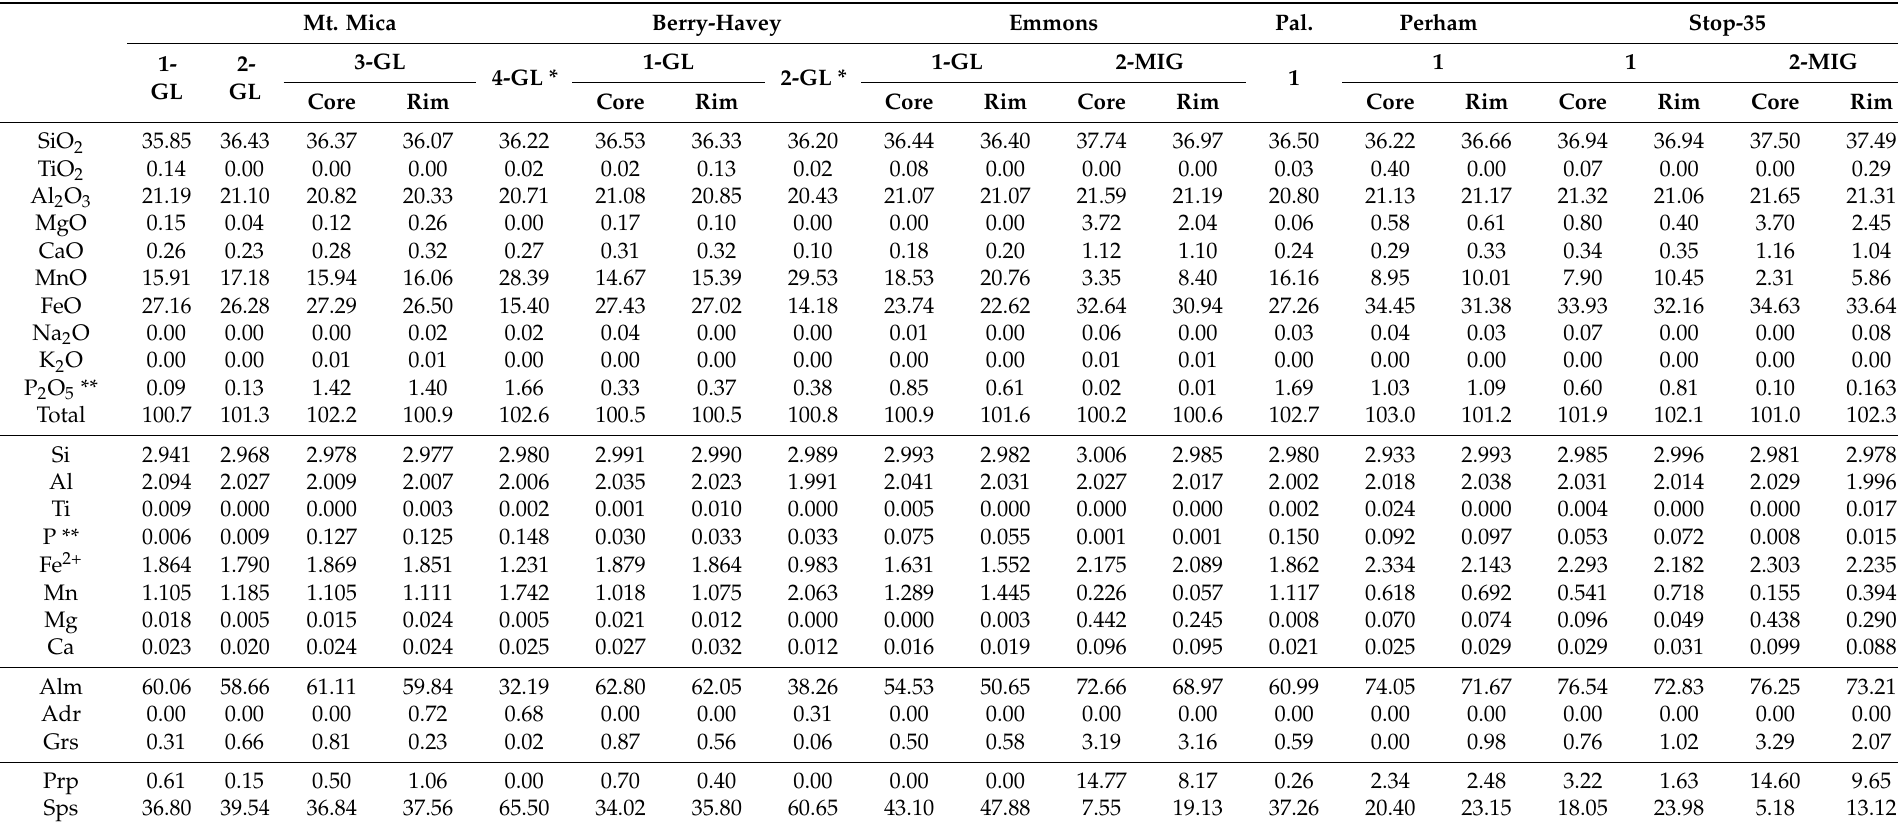
Table 1. Representative microprobe analyses of garnets from the Oxford field pegmatites and migmatites and the Palermo No. 1 pegmatite. Values of the structural formulae normalized to 12 oxygens. Complete dataset available in Table S1 (Supplementary Materials). Mt.